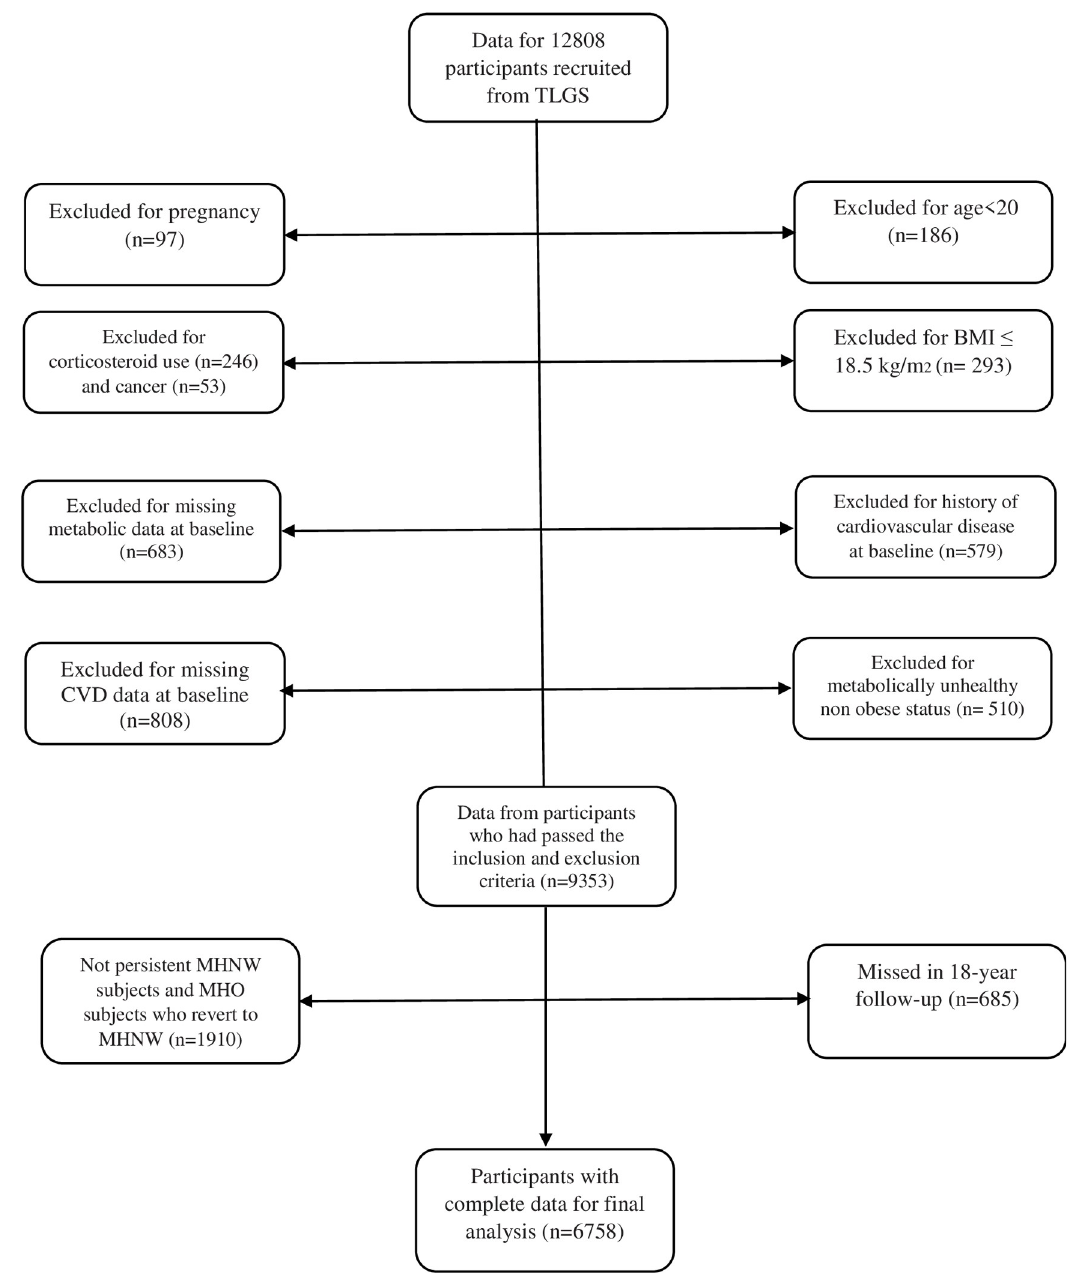
Fig 1. Diagram showing the selection process of study